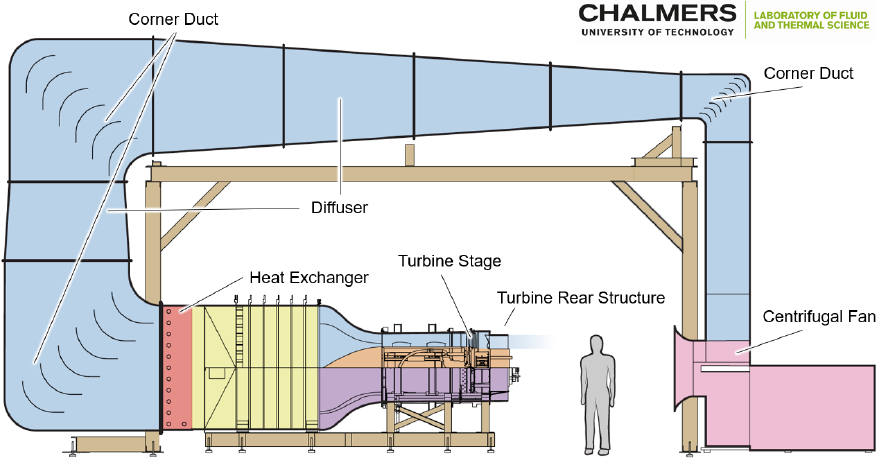
Figure 1. Schematic view of Chalmers OGV-LPT facility.